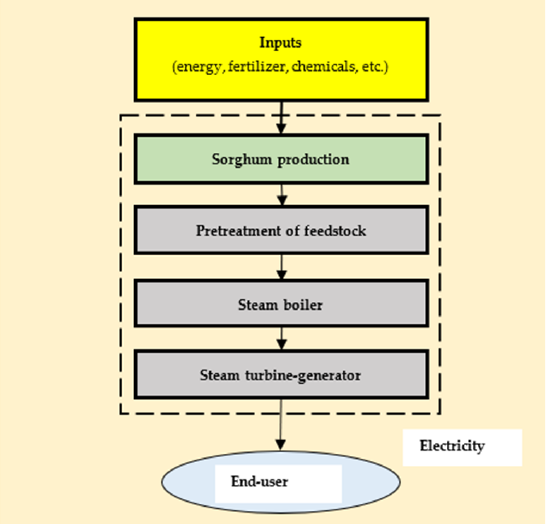
Figure 1. A system boundary of combustion-based biomass power plant. Agriculture 2022 , 12 , x FOR PEER REVIEW